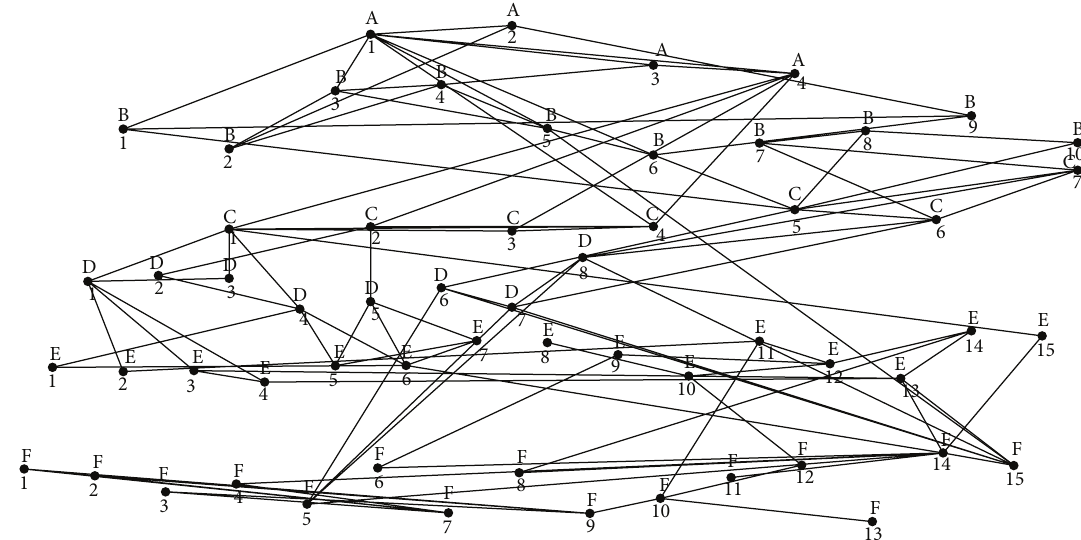
Figure 3: The causation network of the 7.23 China Yongwen railway